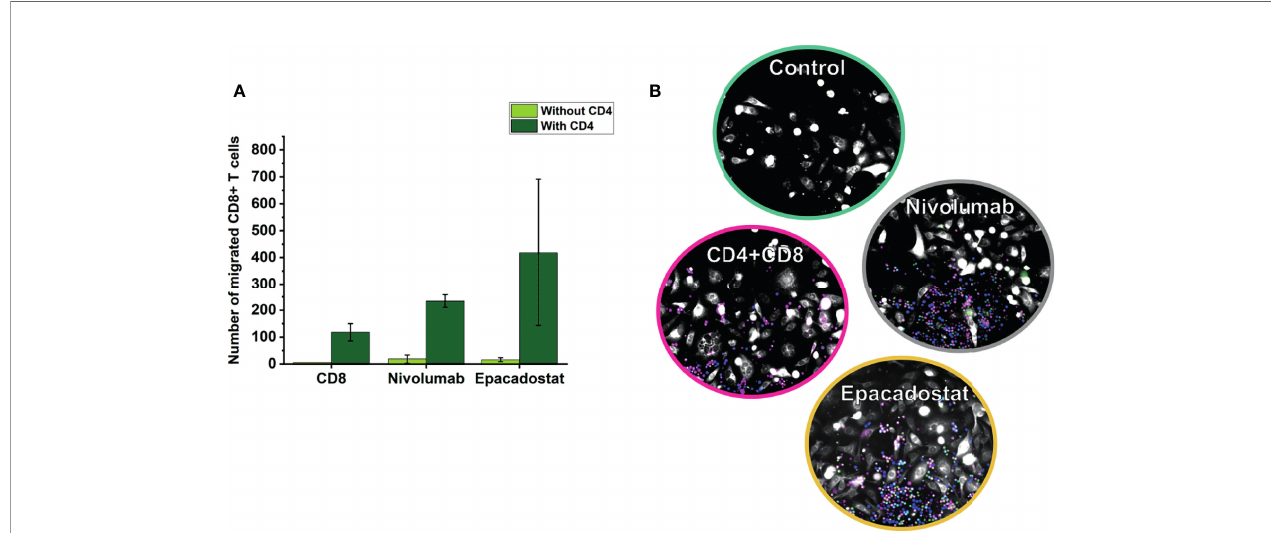
FIGURE 3 | Migration of CD8 + T cells in coculture chips of CD4 + and CD8 + T cells over 3 days. CD8 + T cells overall migrated more in coculture with CD4 + T cells than alone (A) . In the representative image (B) , CD4 + T cells are shown in blue, CD8 + T cells in magenta, cancer cells in white, and apoptotic cells in green. Results are reported as the average number of lymphocytes migrated ± SD. The experiments were repeated two times, each time using a different donor and each in duplicate. Full channel representations are provided as Supplement Figure 4 . CD8=CD8 + T cells, CD4=CD4 + T cells